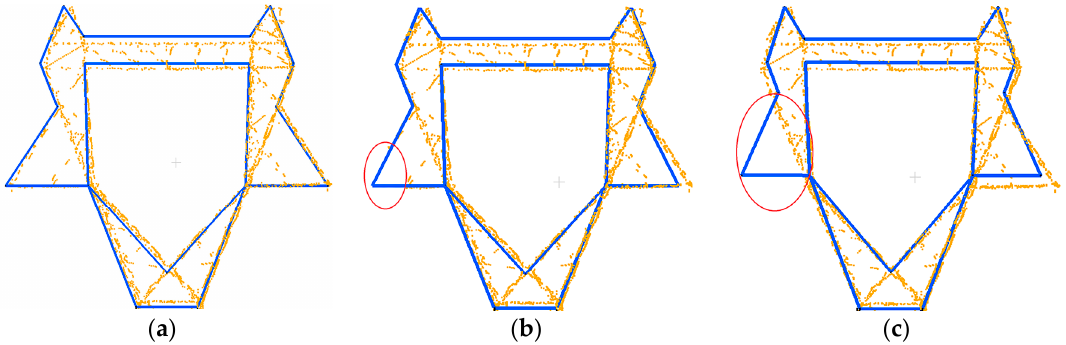
Figure 16. Pylon reconstruction results: ( a ) the result of the head without data loss; ( b ) the head with some data loss; and ( c ) the head data with whole sections of the structure missing.